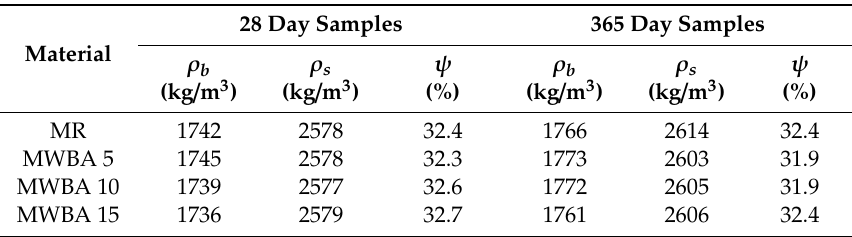
Table 7. Basic structural characteristics of studied